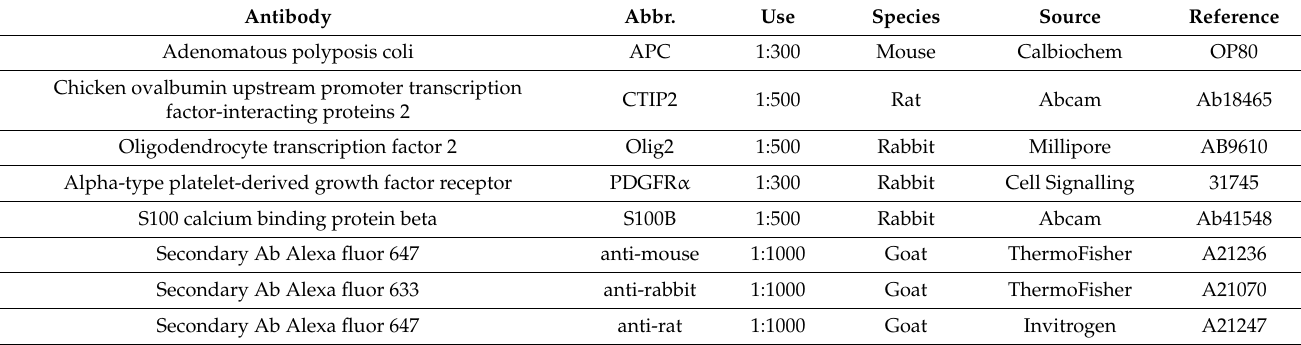
Table 1. List of primary and secondary antibodies for the molecular characterization of neural cells.